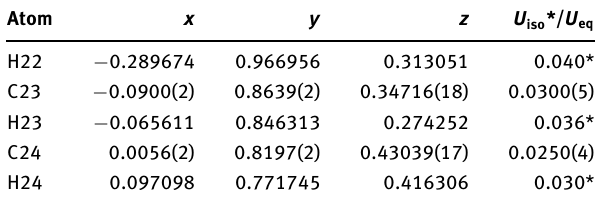
Table 2: Fractional atomic coordinates and isotropic or equivalent isotropic displacement parameters (Å 2